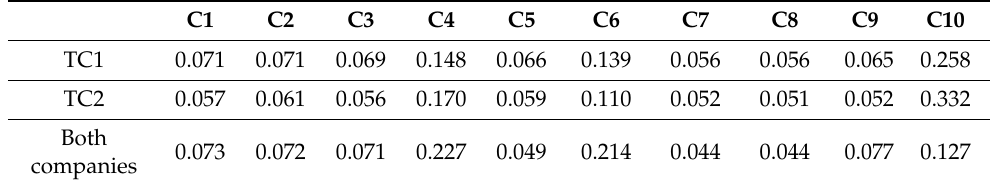
Table 7. Final weight values of the